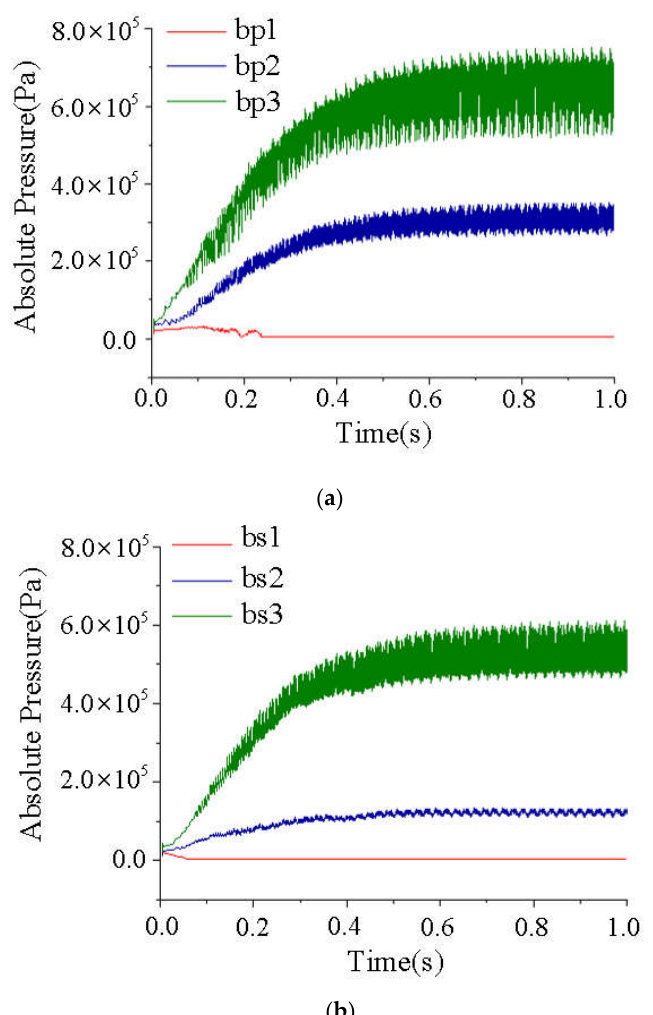
Figure 14. Pressure along the direction of flow of the passage of the blade: ( a ) on the pressure side, and ( b ) on the suction side. and ( b ) on the suction